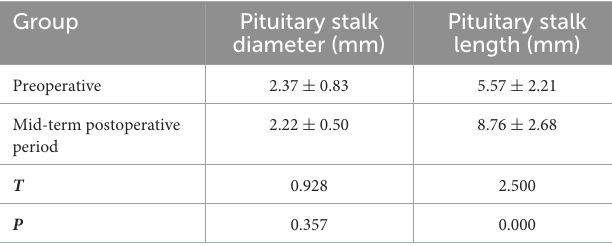
TABLE 2 Relationship between early postoperative diabetes insipidus and